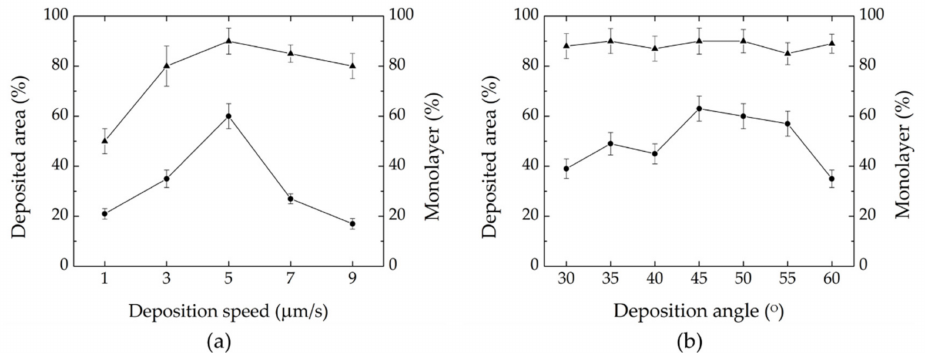
Figure 6. Calculated percentages of deposited area ( • ) and monolayer ( (cid:78) ) of self-assembled PS films with: ( a ) varying deposition speed and ( b ) varying deposition